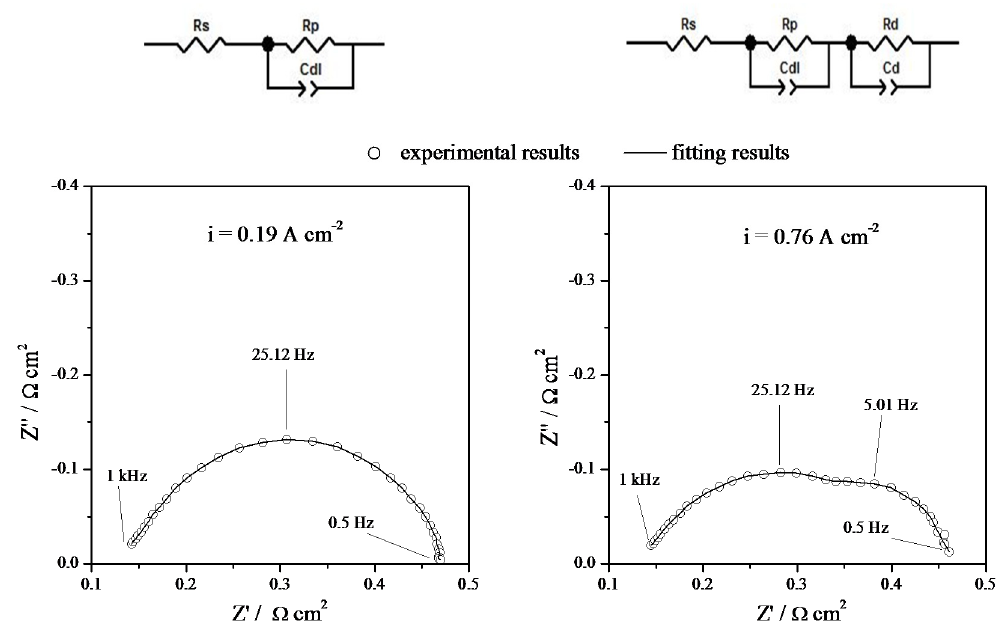
Figure 5. Example of both EIS experimental and fitting results at low (0.19 A cm − 2 ) and high current density (0.76 A cm − 2 ). Equivalent circuits used for fitting procedure are also reported. Sample GDM-PTFE; operating condition: T = 60 °C and RH (A-C) =